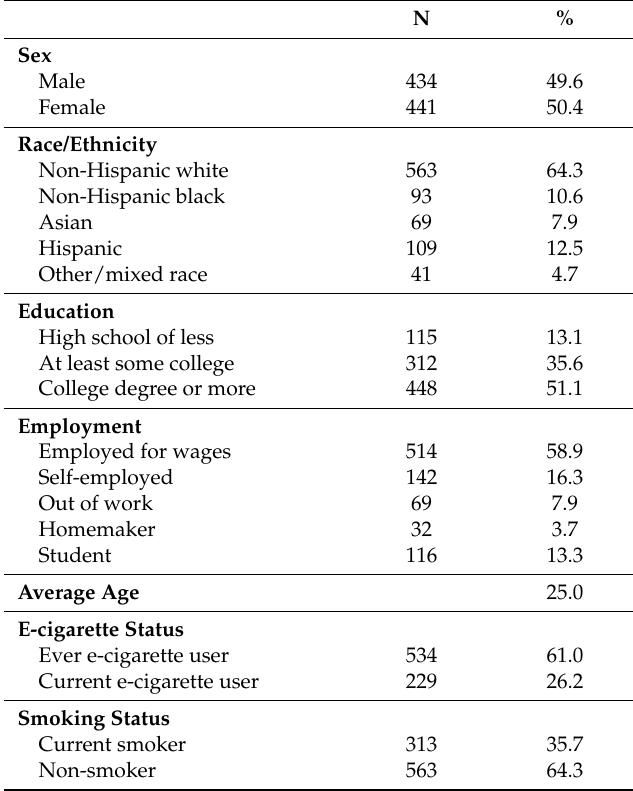
Table 1. Participant demographics and tobacco use (n =